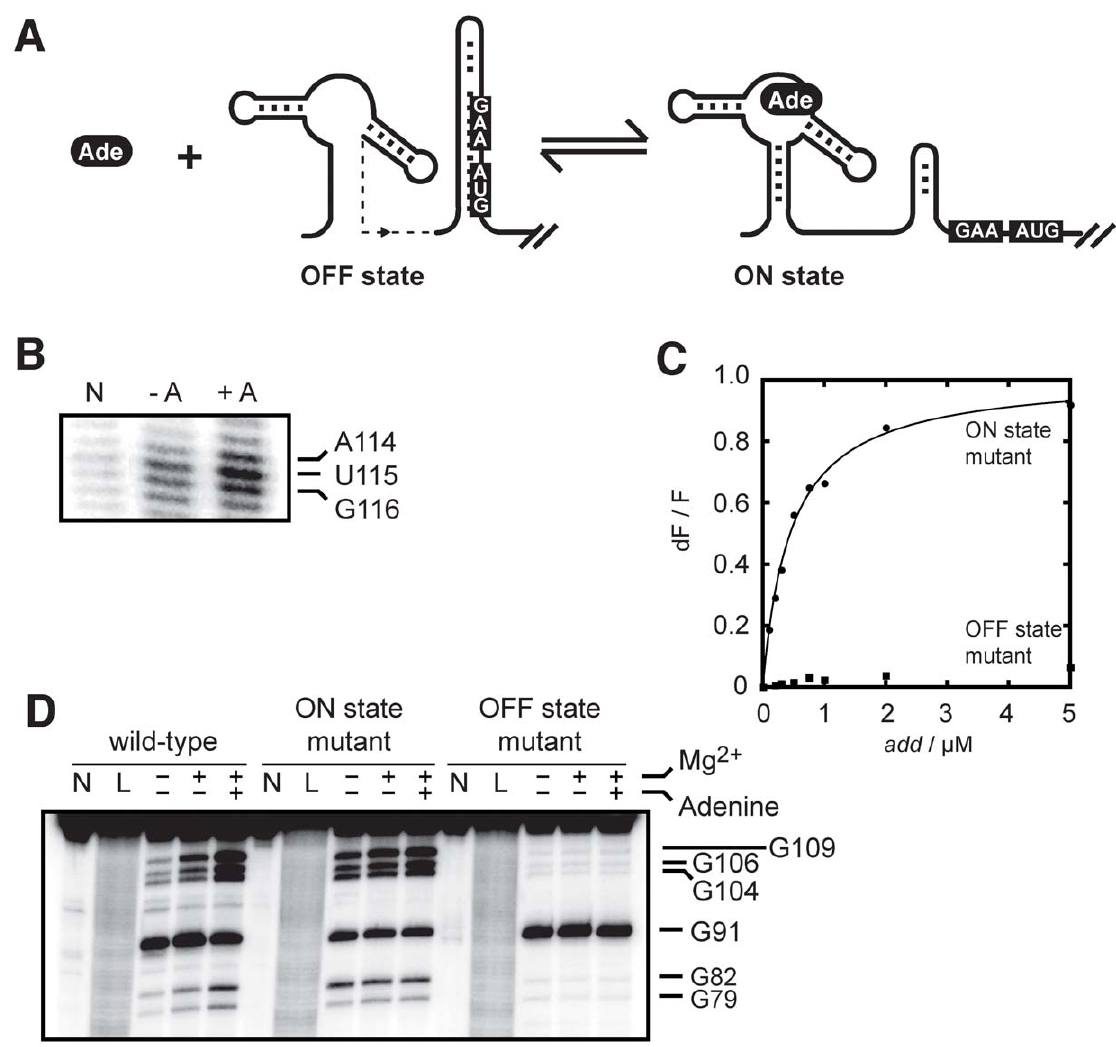
Figure 2. The add riboswitch secondary structure is modulated upon ligand binding. (A) Schematic showing control of gene expression by the add riboswitch upon adenine (Ade) binding. The accessibility of both the Shine-Dalgarno (GAA) and AUG sequences is increased in the ON state. (B) SHAPE modifications of the add riboswitch as a function of adenine concentration. The lane N denotes a reaction in which NMIA was omitted. SHAPE reactions were performed in absence ( 2 A) and in presence of 10 m M adenine ( + A). The AUG sequence showing increased accessibility in presence of adenine is indicated on the right. The complete gel is shown in Figure S2. (C) Normalized 2AP fluorescence intensity plotted as a function of add riboswitch ON (circles) and OFF (squares) state mutants. The sequence changes are shown in Figure 1B. An apparent binding affinity (K Dapp ) of 458 6 33 nM was obtained for the ON state mutant. No value was determined for the OFF state mutant due to the absence of significant fluorescence change. (D) RNase T1 partial cleavage of the add riboswitch showing the structural change of the expression platform in presence of adenine. Digestions were also done for the ON and OFF state mutants. Lanes N and L represent samples that were not reacted and that were subjected to partial alkaline digestion, respectively. Nuclease digestions were performed as a function of 10 mM magnesium ions and 10 m M adenine. Substantial cleavage sites are indicated on the right. The complete gel is shown in Figure S3.